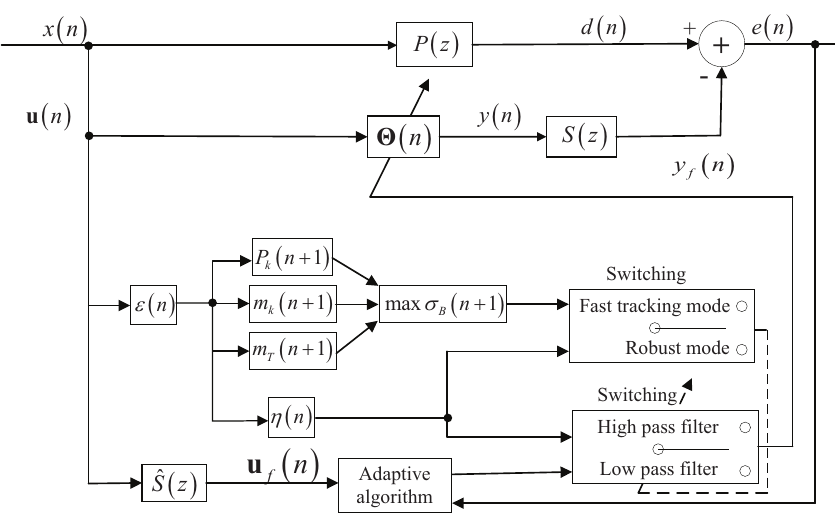
Figure 2. Block diagram of the proposed DMPFxNLMS